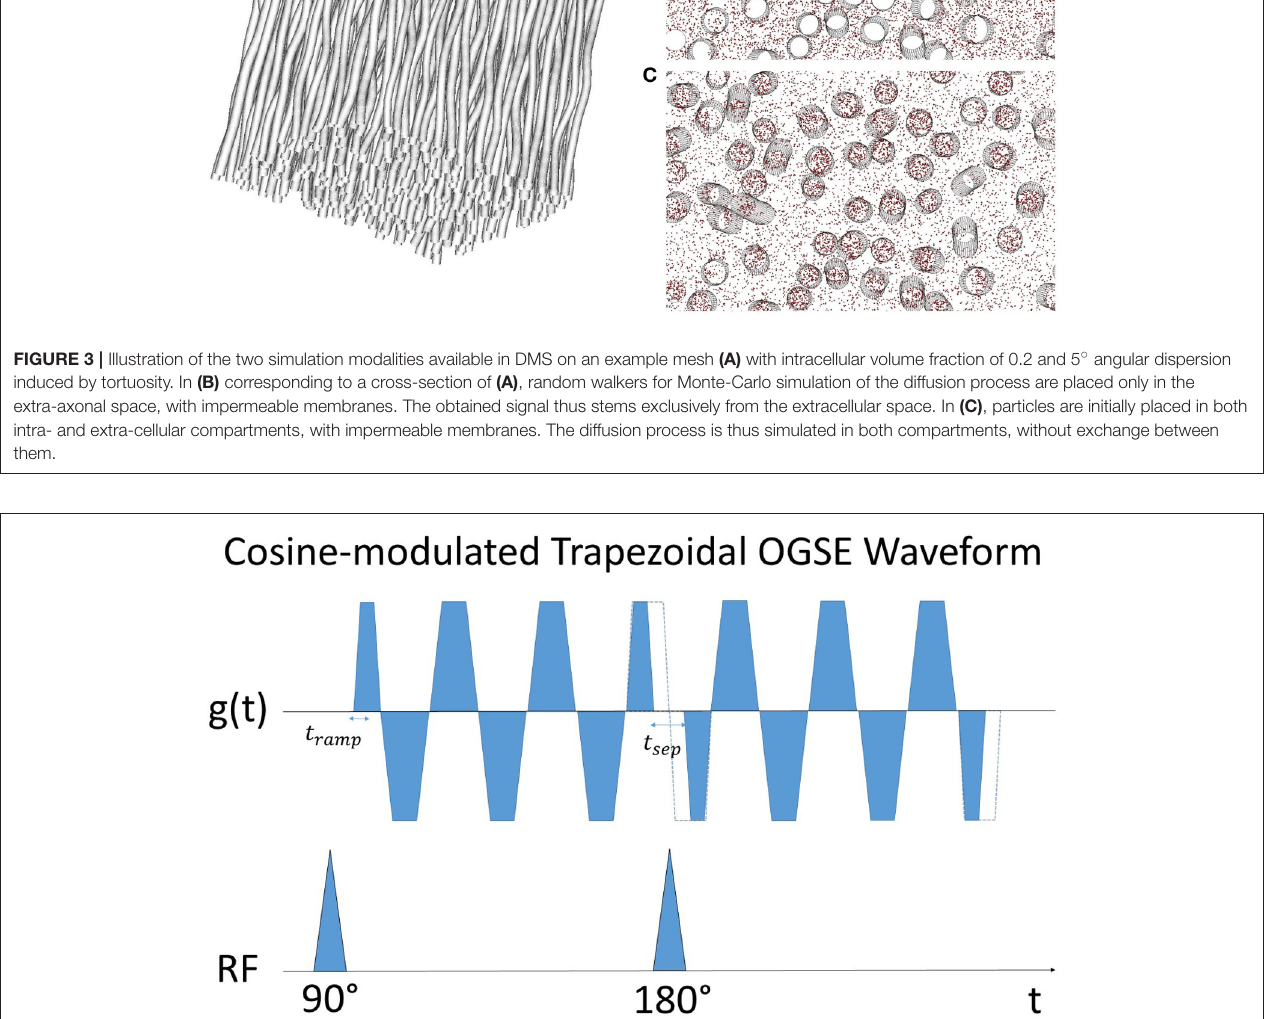
maximum gradient magnitude (respectively 200 T / m / s and 80 mT / m corresponding to the latest Connectome gradient coils available for 3T MRI systems on the